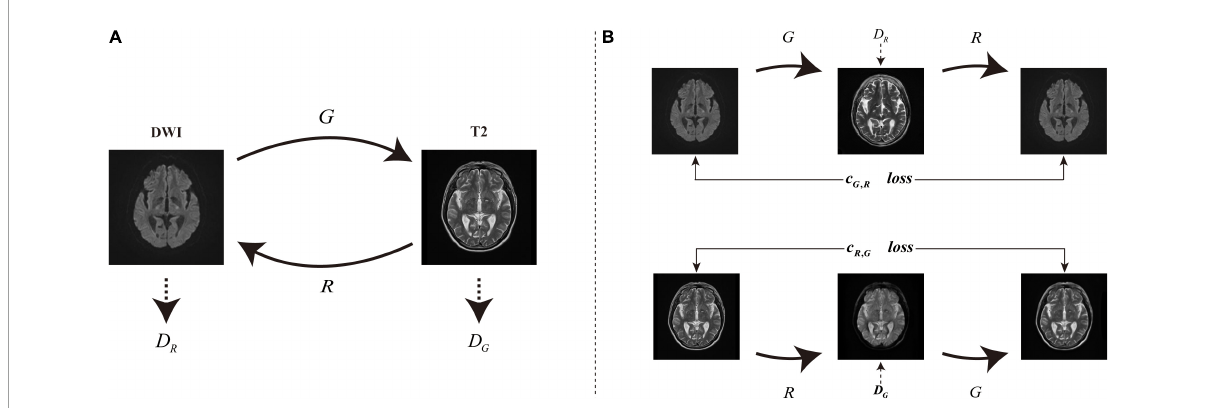
FIGURE3 (A) Two generator mapping models G : DWI → T 2 and R : T 2 → DWI , and two associated adversarial discriminators D G and D R . D G distinguishes between the images generated by G and T2, and vice versa for D R and R. (B) Two consistency loss c G , R : DWI → G ( DWI ) → R ( G ( DWI )) ≈ DWI and c R , G : T2 → R ( T2 ) → G ( R ( T2 )) → T2 to further regularize the